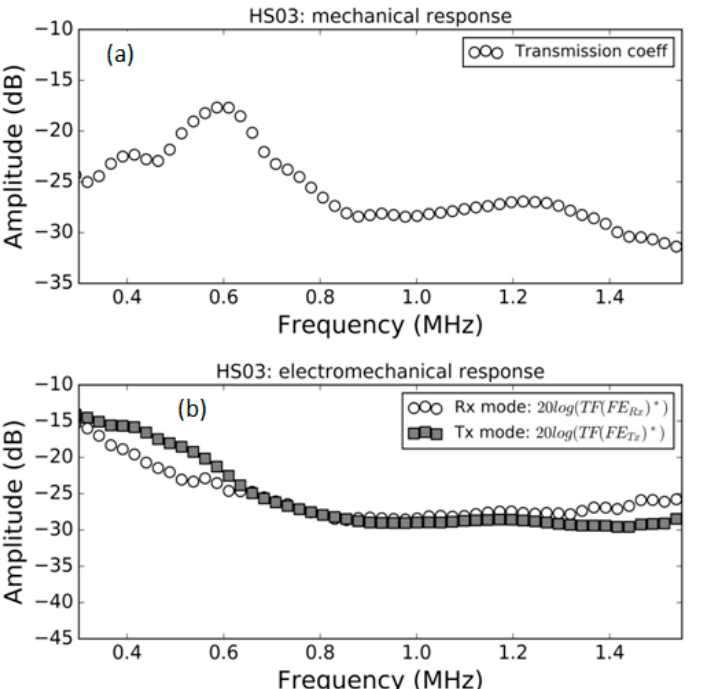
Figure 8. Measured response of the HS03 FE sample in water. ( a ) Modulus of the transmission coefficient vs. frequency; ( b ) electromechanical response vs. frequency both in Tx and Rx mode, (see Equations (16) and (22)).